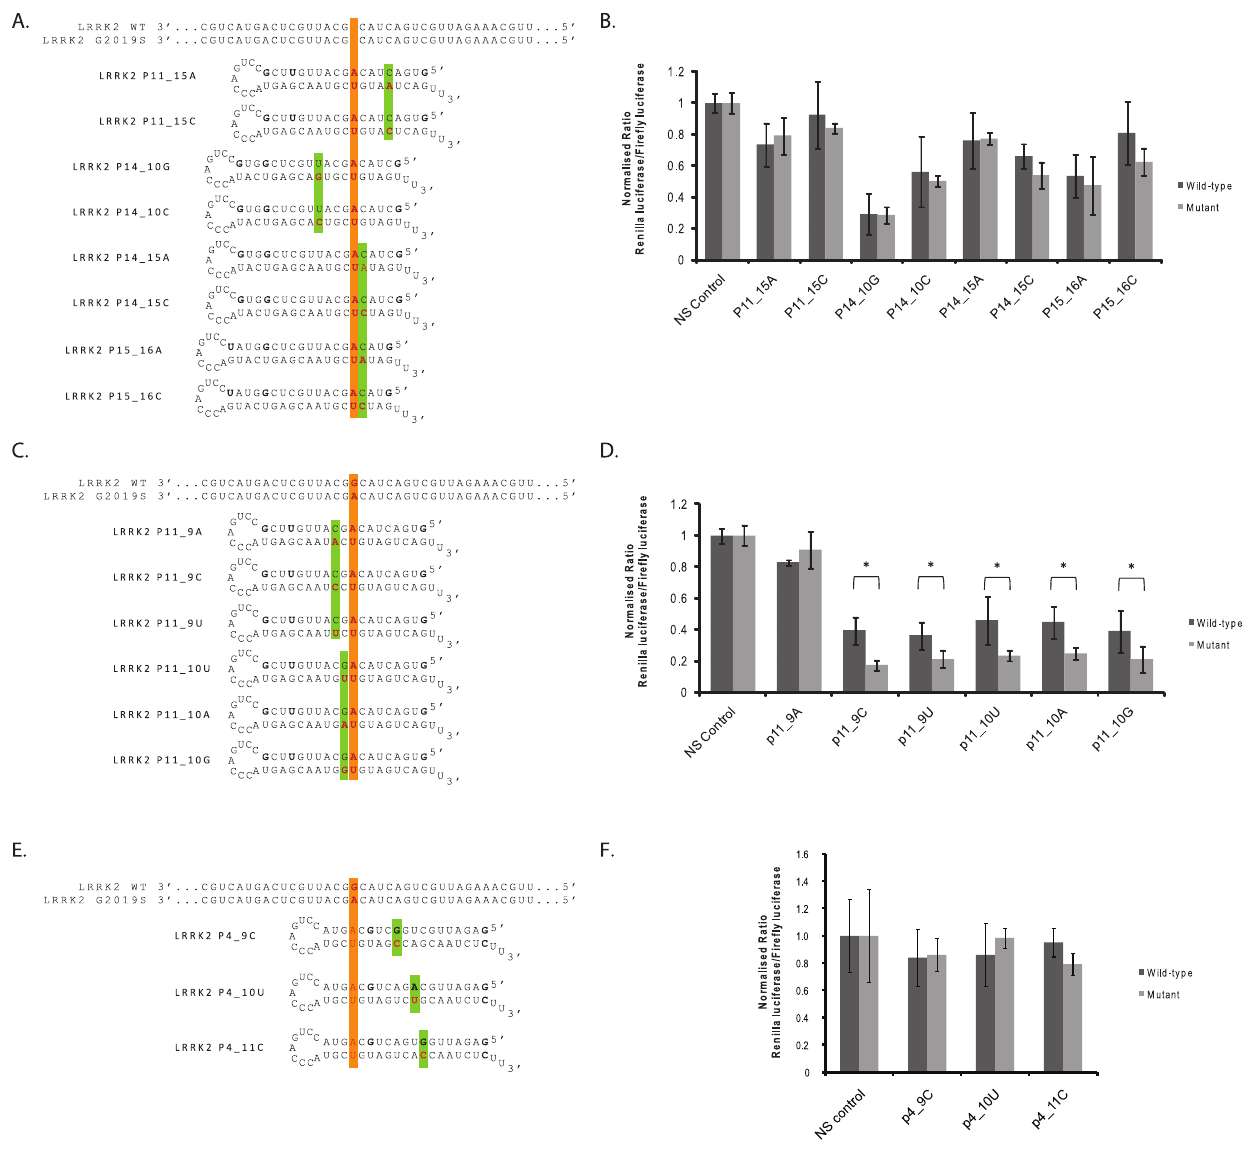
Figure 6. Screening of G2019S-targeting shRNAs incorporating secondary mismatches to wild-type LRRK2 against dual-luciferase targets. A, C and E) shRNAs were designed targeting the G2019S mutant allele of LRRK2 with the G2019S mutation aligned at stated positions in the 3 9 region of the antisense species. Secondary mismatches to the wild-type allele were additionally made at indicated positions in the antisense species such that two mismatches are present to the wild-type target, and one mismatch to the G2019S mutant target. B, D and F) Dual-luciferase reporter assays at 48 hrs post-transfection with double mismatch shRNAs targeting the G2019S LRRK2 mutant following co-transfection with wild- type (dark bars) or mutant (light bars) luciferase targets. Values represent mean ratios of Renilla :Firefly luciferase + / 2 S.D. from n=6. Values are normalized to cells transfected with non-specific shRNA and respective luciferase target. *=P , 0.05 relative to respective normalising control.